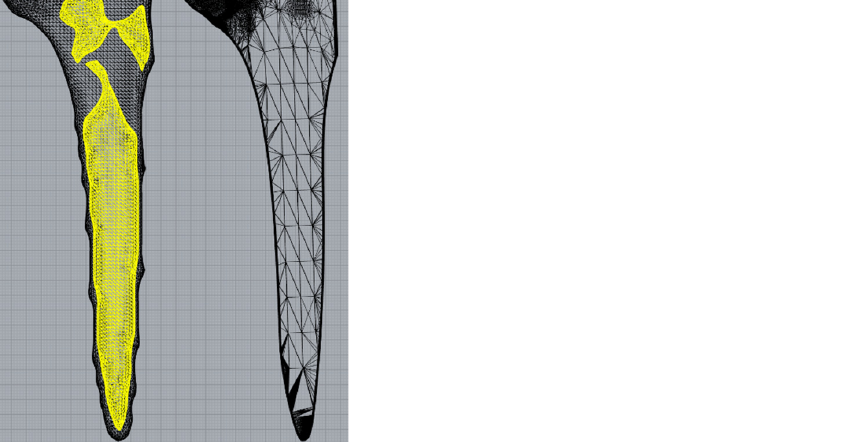
Figure 3. Internal geometry (yellow) separated from the rough external geometry (left) before being placed inside a standard implant (right).